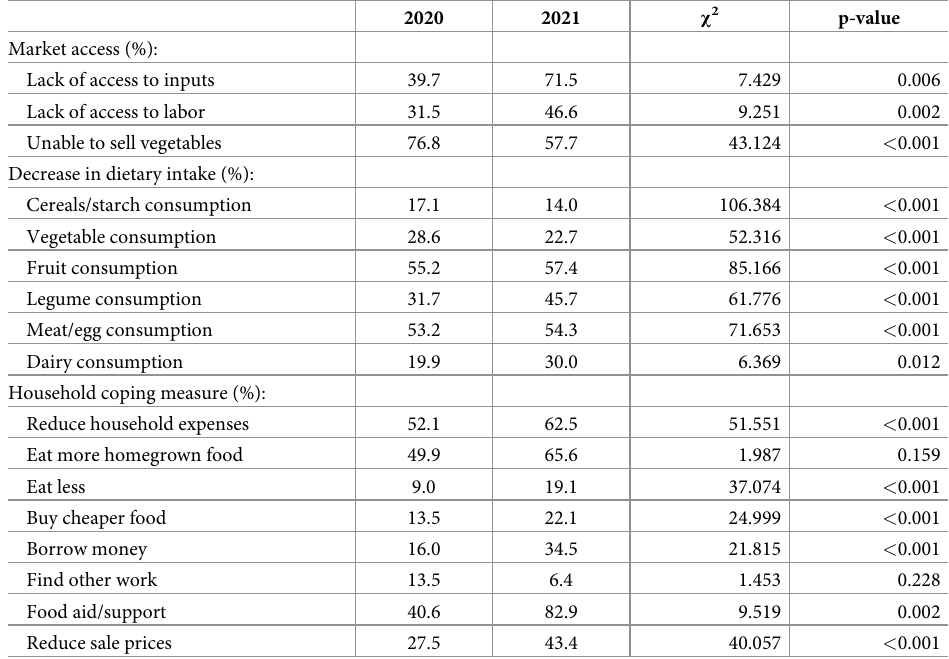
Table 2. Change in market access, diets and coping measures between 2020 and 2021, n =